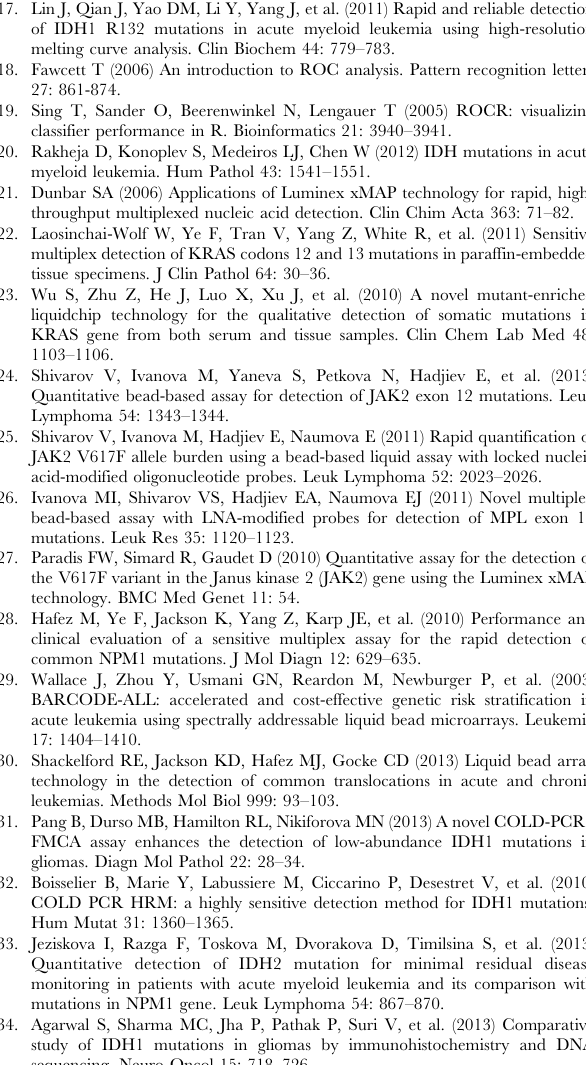
Figure S1 Curve fitting with hyperbolic regression model for all mutants obtained at 68 6 C hybridization. Figure S2 Determination of the optimal hybridization temperature. (A) Distribution of the deltaMFI values for all mutants at the three different temperatures (p , 0.0001 on Kruskal-